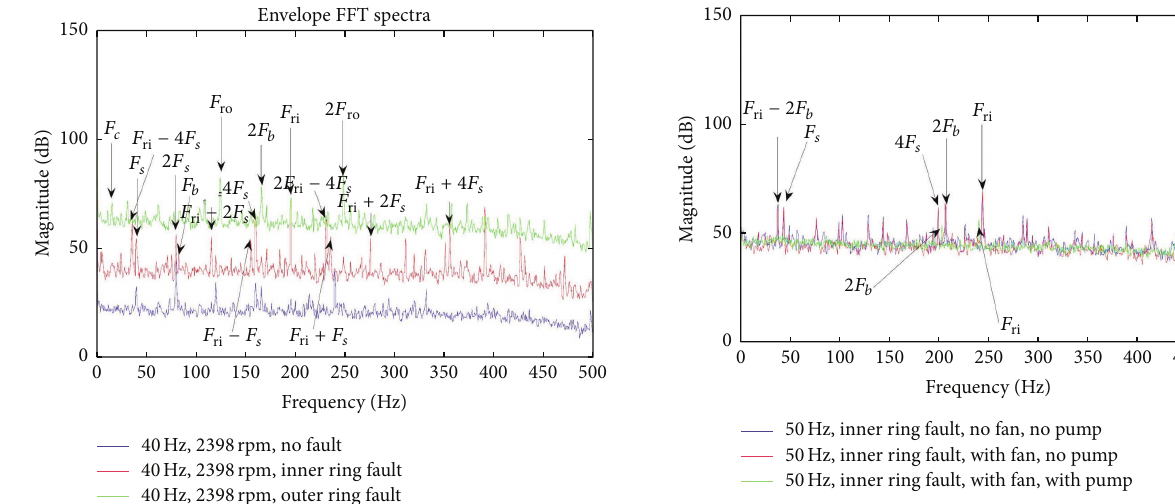
Figure 7: Nominal, inner defect, and outer defect spectra of 40Hz motor input, free load condition, and radial vibration measure- ments.